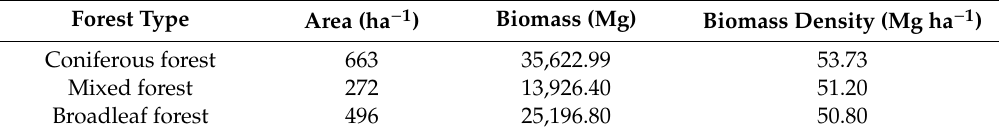
Table 7. Biomass and biomass density of each forest